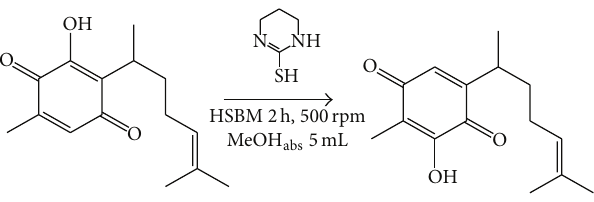
Scheme 2: Transformation of perezone into